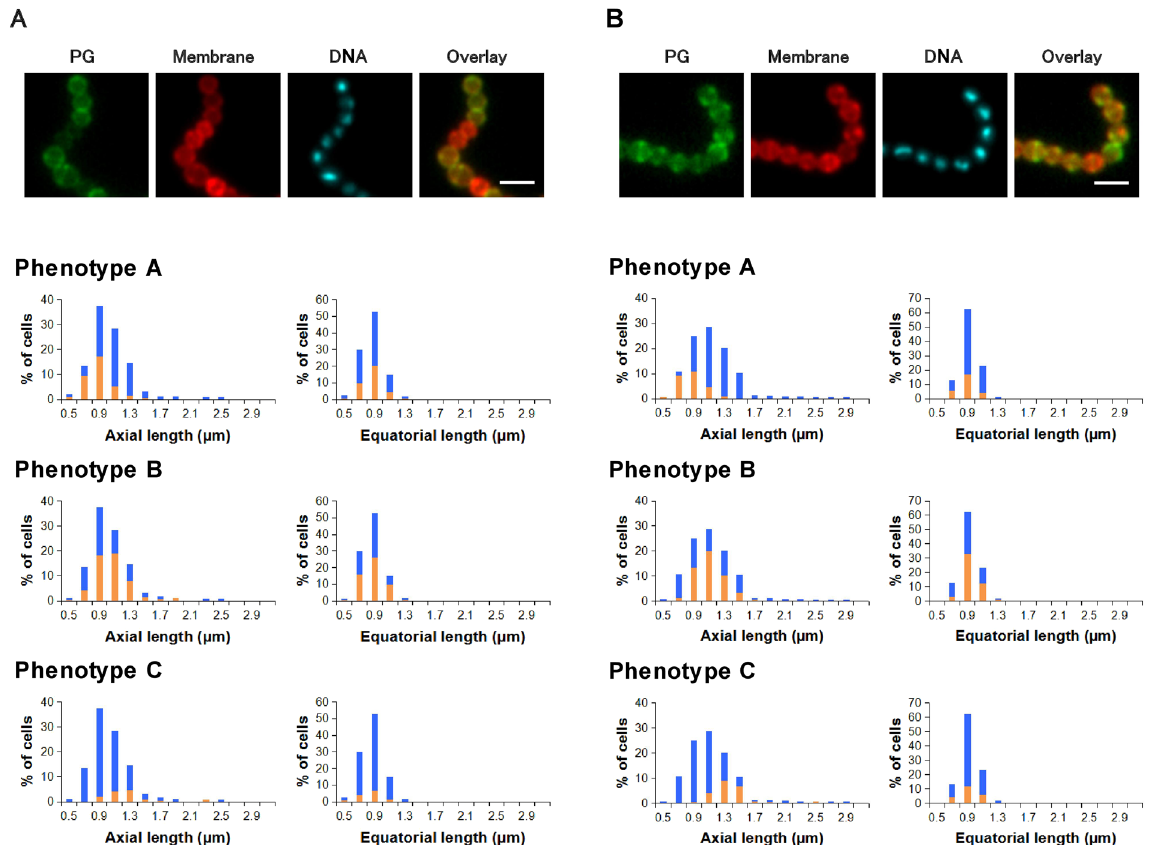
Figure 2. Average distribution of cell sizes and phenotypes of bacitracin (4 μ g/mL)-treated Streptococcus pyogenes ( A ) and ramoplanin (2 μ g/mL)-treated S . pyogenes ( B ) (n = 3). Images: PG (growing peptidoglycan stained using the sortase method), Membrane (Nile red staining), DNA (DAPI), and Overlay (overlay of PG and Membrane images); scale bar: 2 μ m. Blue bars in histograms represent the cell size distribution of all cells. Orange bars in histograms represent the size distribution cells with the indicated phenotypes. Statistical analysis regarding the histograms is available in Supplementary Table